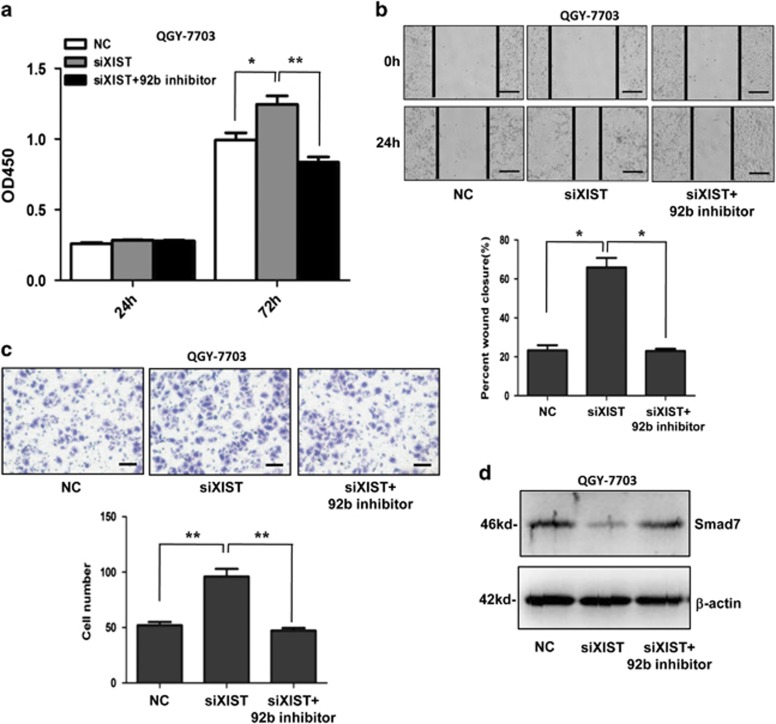
Effects of XIST and miR-92b knockdown on proliferation and metastasis of HCC cells. QGY-7703 cells were co-transfected with siXIST plus miR-92b inhibitor or NC inhibitor. (a) CCK-8 assays, (b) wound healing assays, (c) transwell invasion assays and (d) western blot assays for Smad7 were performed. The percent of wound closure and the number of cells that passed through the membrane were counted and compared in the diagrams. Results were represented as mean±S.D. (n=3). *P<0.05; **P<0.01. Scale bars represent 500 μm (b) and 200 μm (c), respectively